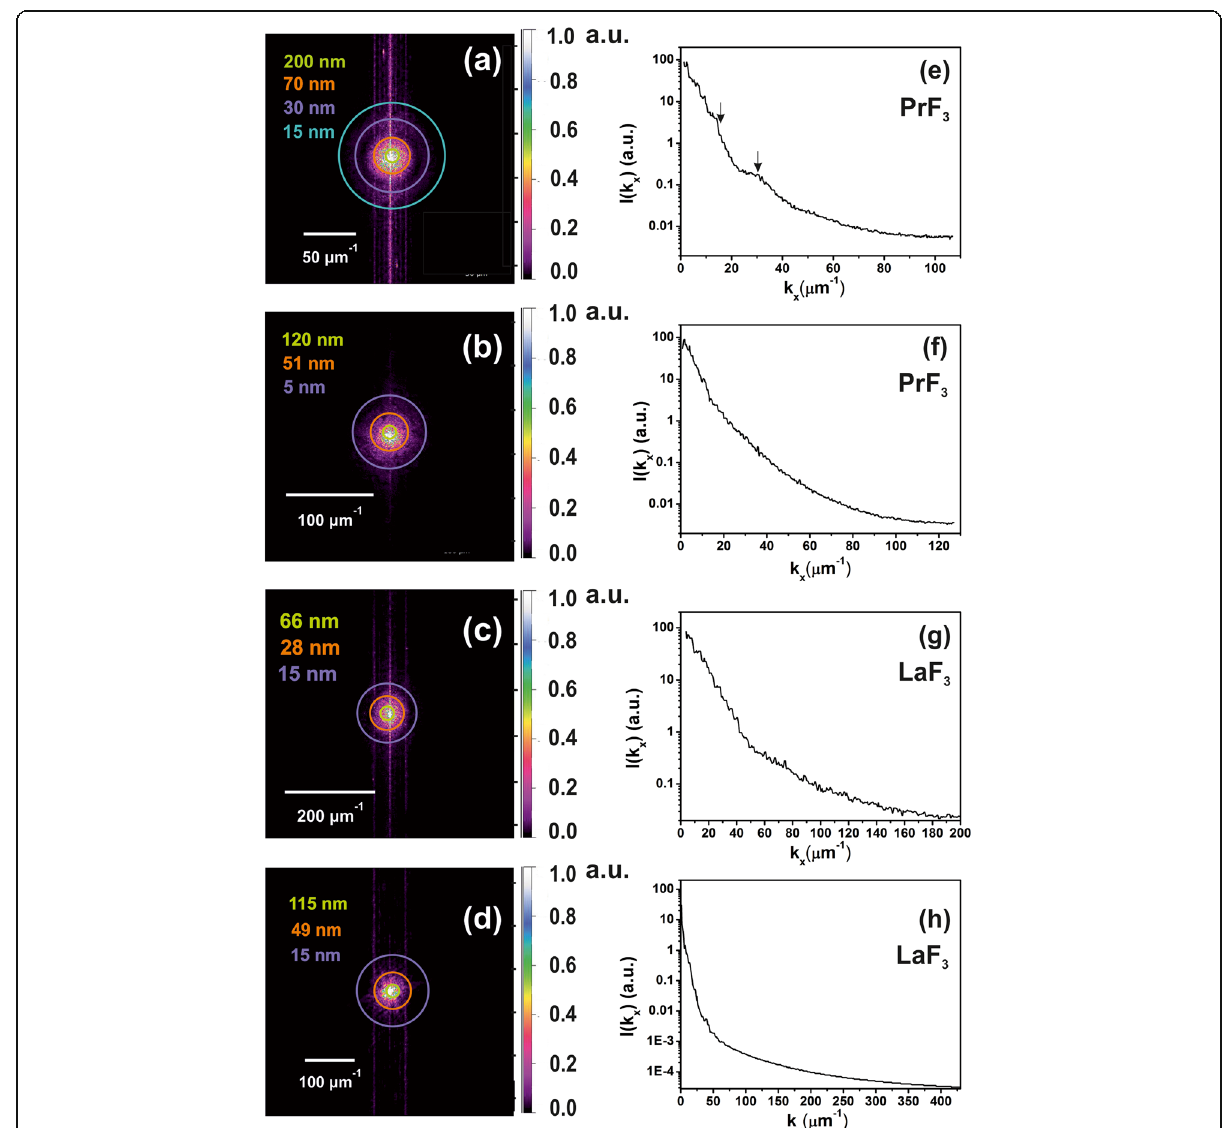
Fig. 6 2D-FFT spectra of z -height distribution of dried RE-NPs in DMEM+FBS media evincing the presence of small-sized NPs in the liquid suspensions. a , b z-height distribution of PrF 3 NPs from AFM images, Fig. 2(a1, b1). Small z -height features (~ 5 nm) were identified in ( b ). c , d z-height distribution of LaF 3 NPs from AFM images, Fig. 2(c1, d1). e , f Power spectra of z -height wave vectors of PrF 3 NPs along the x -axis. g , h Power spectra of z -height wavevectors of LaF 3 NPs along the x